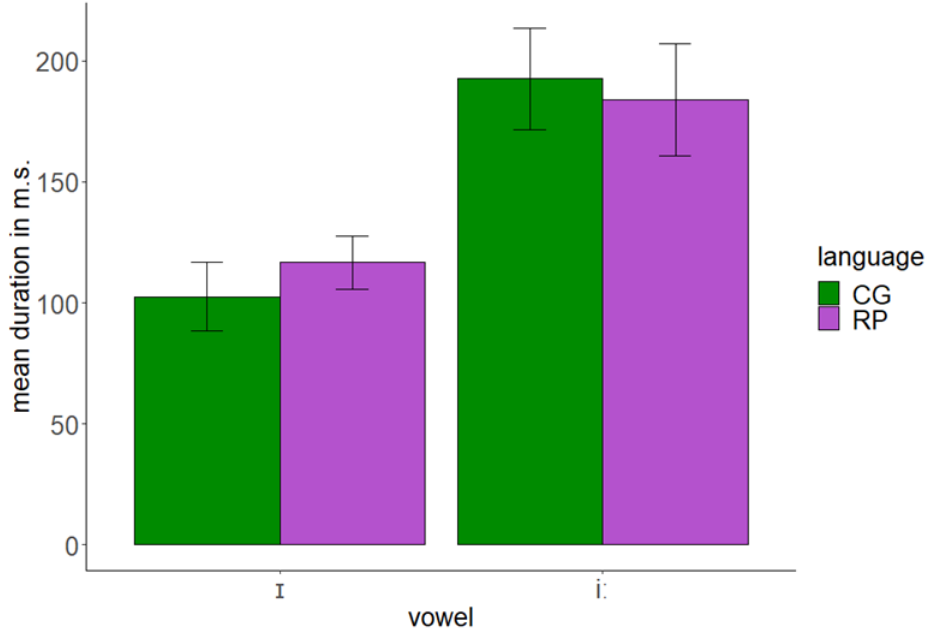
Figure 4. Duration of English / ɪ / and /i ː / as produced by CG and RP speakers.